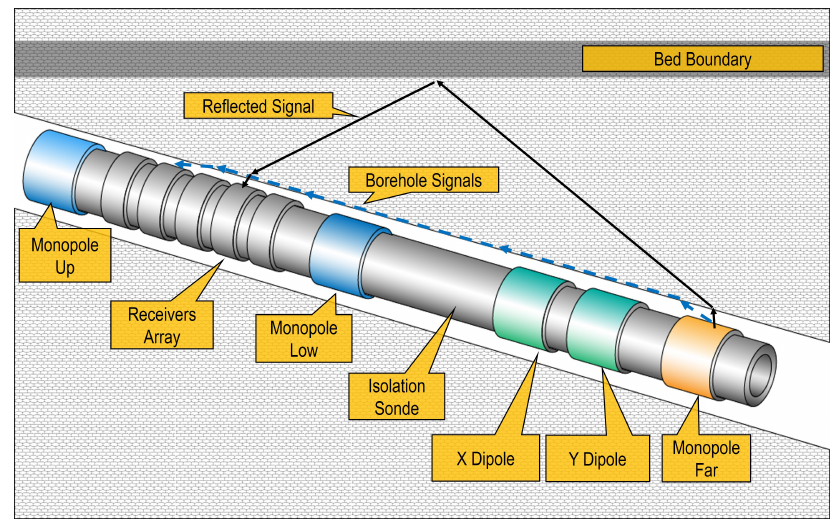
Figure 12. Tool schematic for the borehole acoustic-reflected survey and bed boundary detection. Directional acoustic measurements are achieved by cross-directional dipole